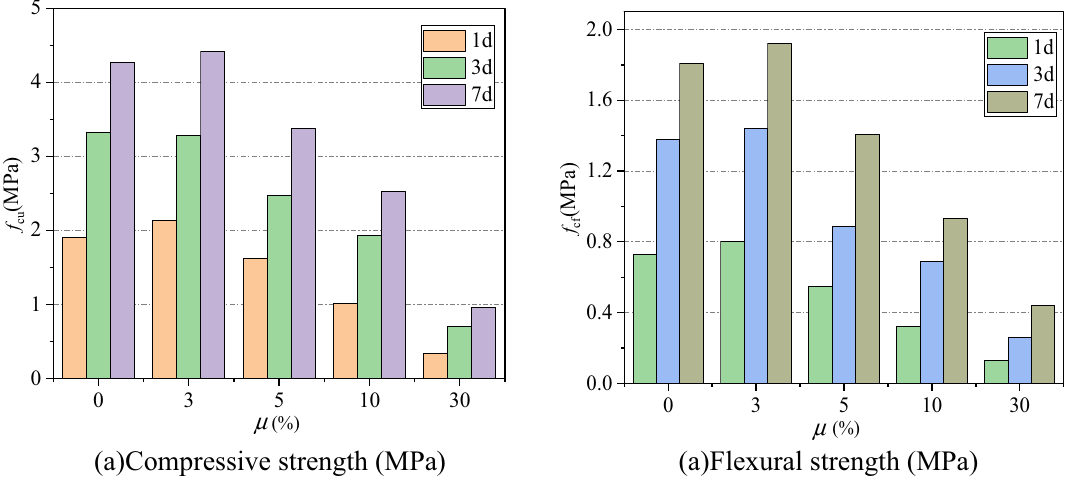
Figure 3. Influence of MSWI fly ash dosage on mechanical properties of